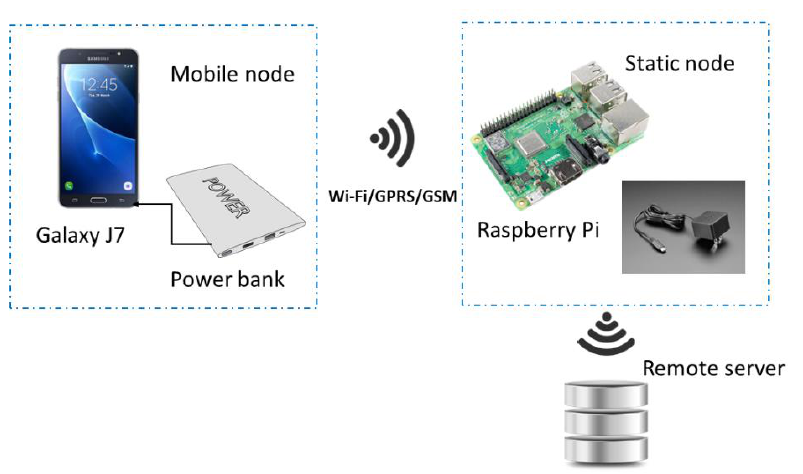
Figure 4. Interconnection diagram of the nodes, including the mobile node placed in the Metrobus bus and the static node placed in each station.